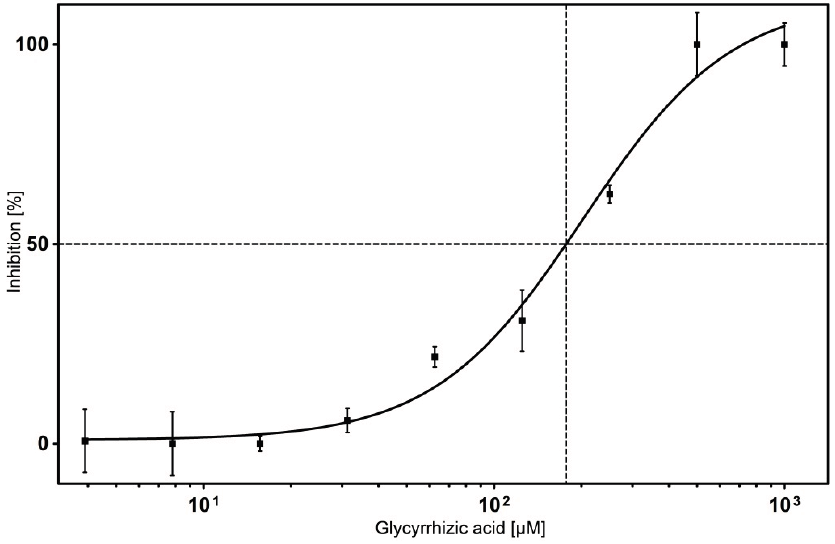
Figure 7. IC 50 value determination of glycyrrhizic acid. Inhibition of surface displayed Hyal-1 was measured after incubation with glycyrrhizic acid at concentrations ranging from 0 to 1 mM. Calculation of IC 50 values was done using GraphPadPrism5 Software. The IC 50 value was calculated from the inflectionpoint (50% inhibition of the Hyal-1 activity) of the plot ( n = 3, error bars ±